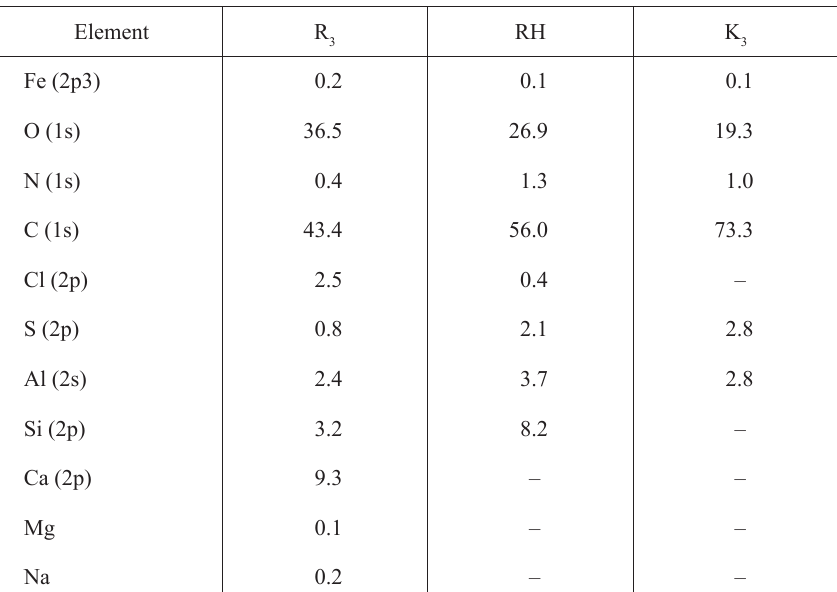
Table 2. XPS analysis of the starting materials, atomic